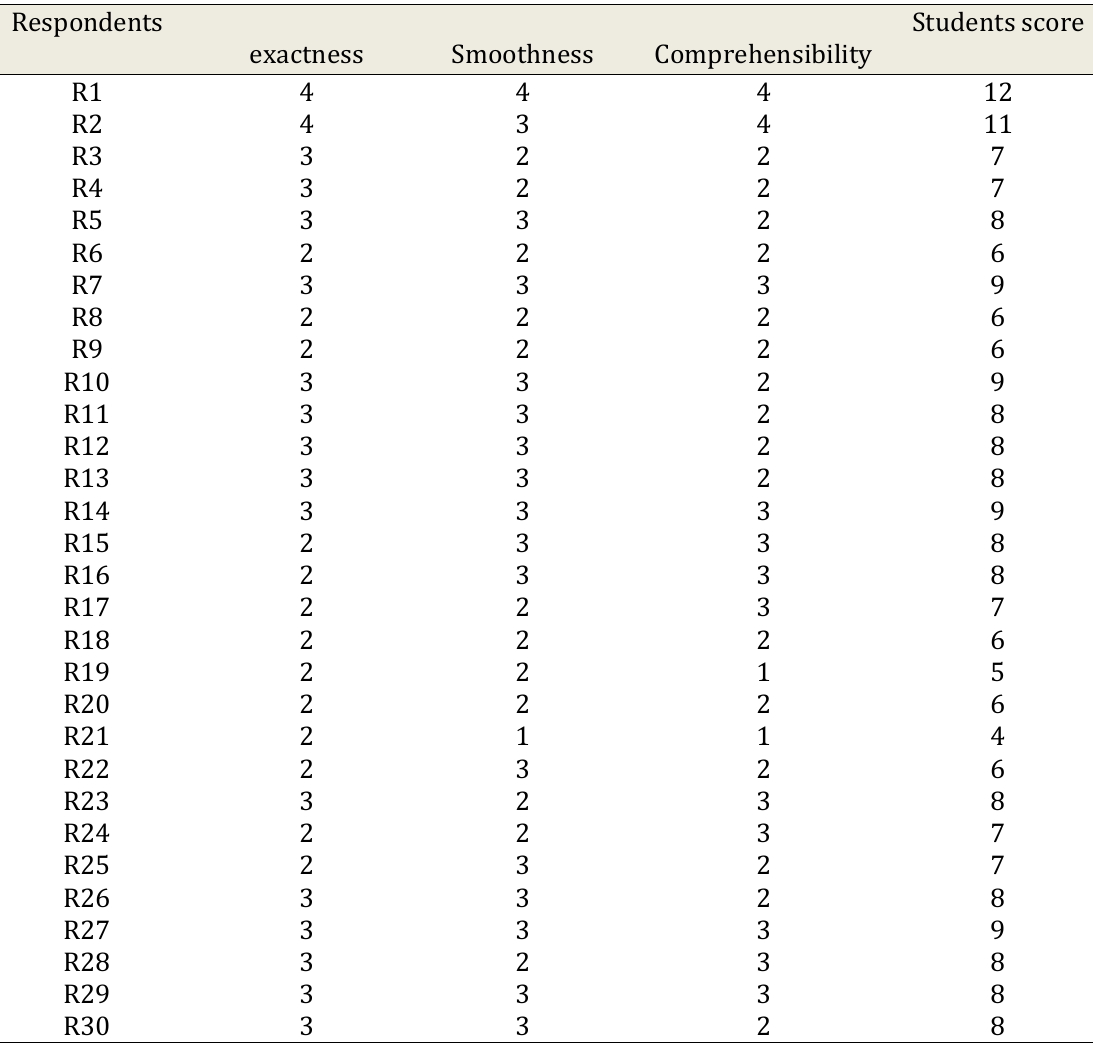
Table 4.3 The of students' score Rate Percentage Accuracy in Pretest Result in Class